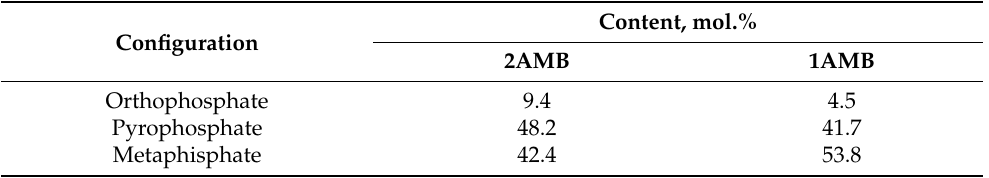
Table 5. Relative contents of different structural phosphate units in the materials, based on the compositions 1A and 1AMB.